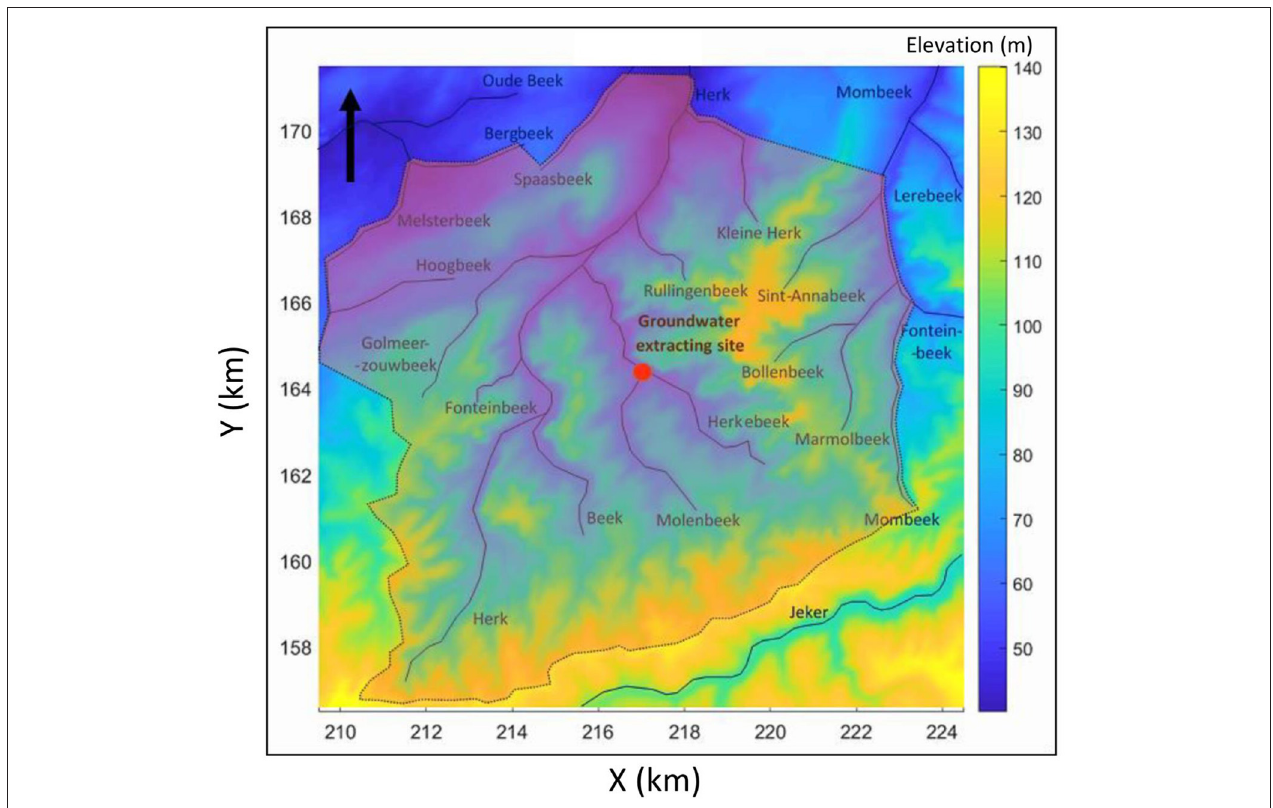
FIGURE 6 | Digital elevation model of the study area with the river network and the delimitation of the